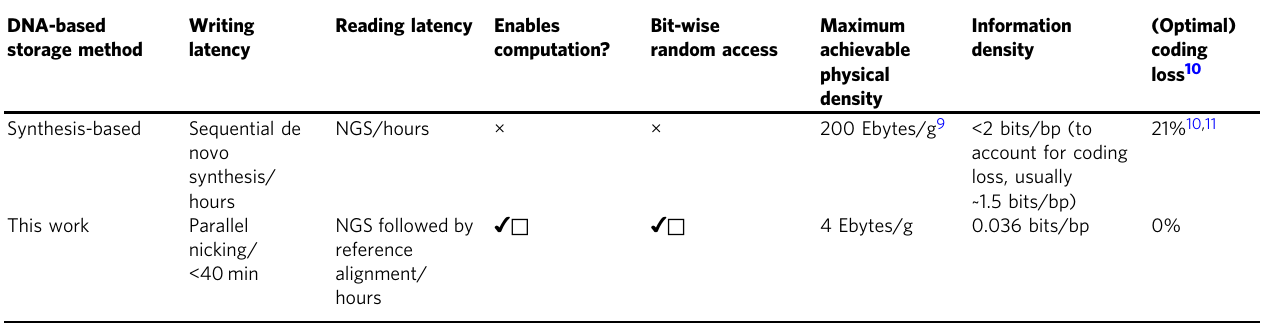
Table 1 Comparison of synthetic and native DNA-based data storage platforms. DNA-based storage